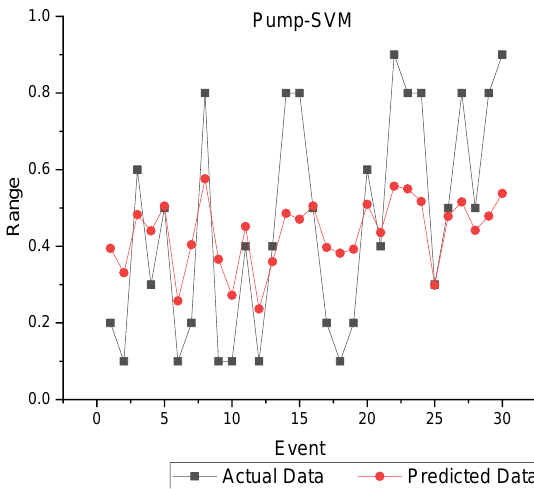
Figure 12. Representation of evaluation time.